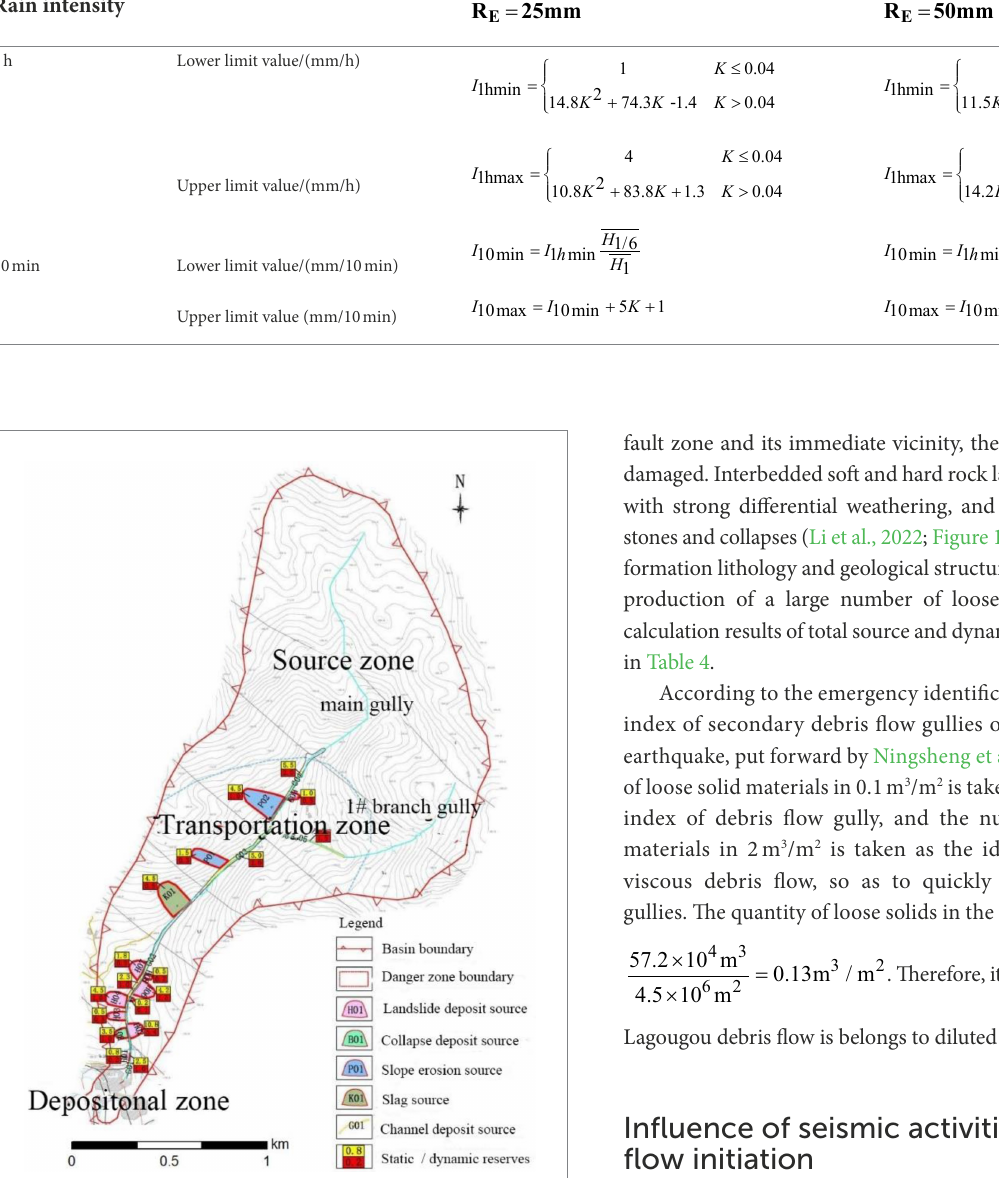
FIGURE 7 Distribution of loose solid materials in the